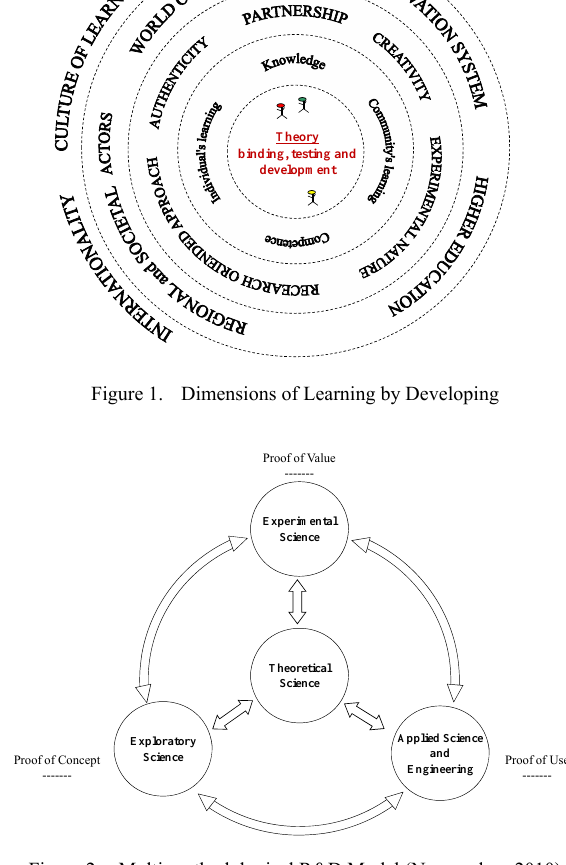
Figure 2. Multi-methodological R&D Model (Nunamaker,